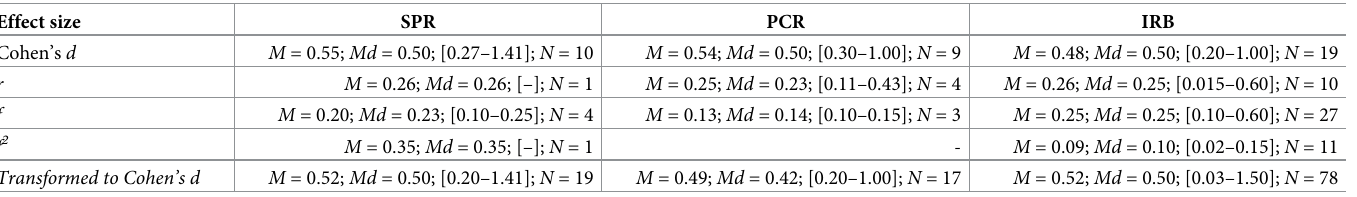
Table 2. Mean ( M ), Median ( Md ), [range], and frequency ( N ) of the different effect sizes used in the power analyses (Cohen’s d , r , f , and f 2 , effect sizes transformed to Cohen’s d ) for each of the registration type